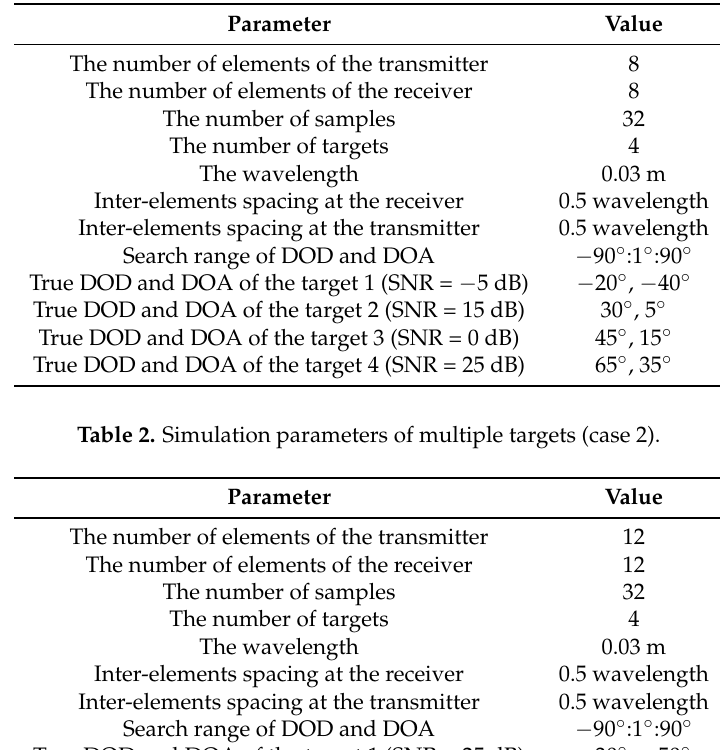
Figure 8. Spectrum of the bistatic conventional beamforming algorithm, the number of targets = 4 (case 1). Table 1. Simulation parameters of multiple targets (case 1).